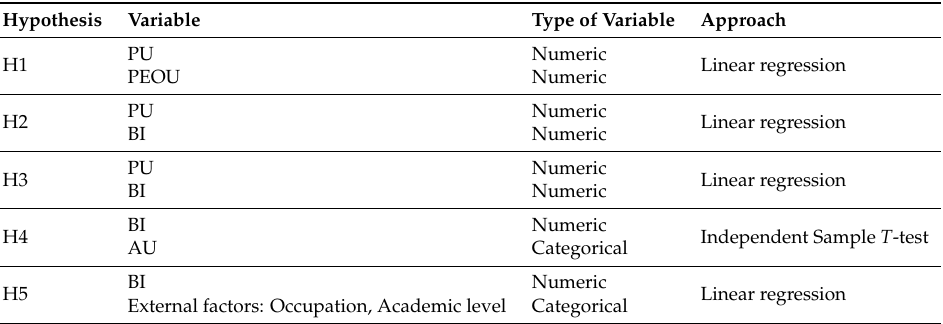
Table A4. Summary of approaches for hypotheses testing.